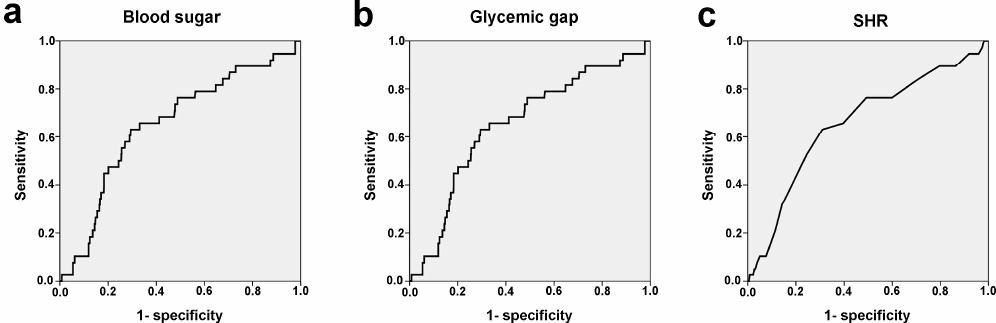
Figure 4. Receiver operating characteristic (ROC) curve analysis to identify cut-off levels for mortality by different parameters, including ( a ) blood sugar (mg/dL), ( b ) glycemic gap (mg/dL) and ( c ) stress hyperglycemia ratio (SHR).